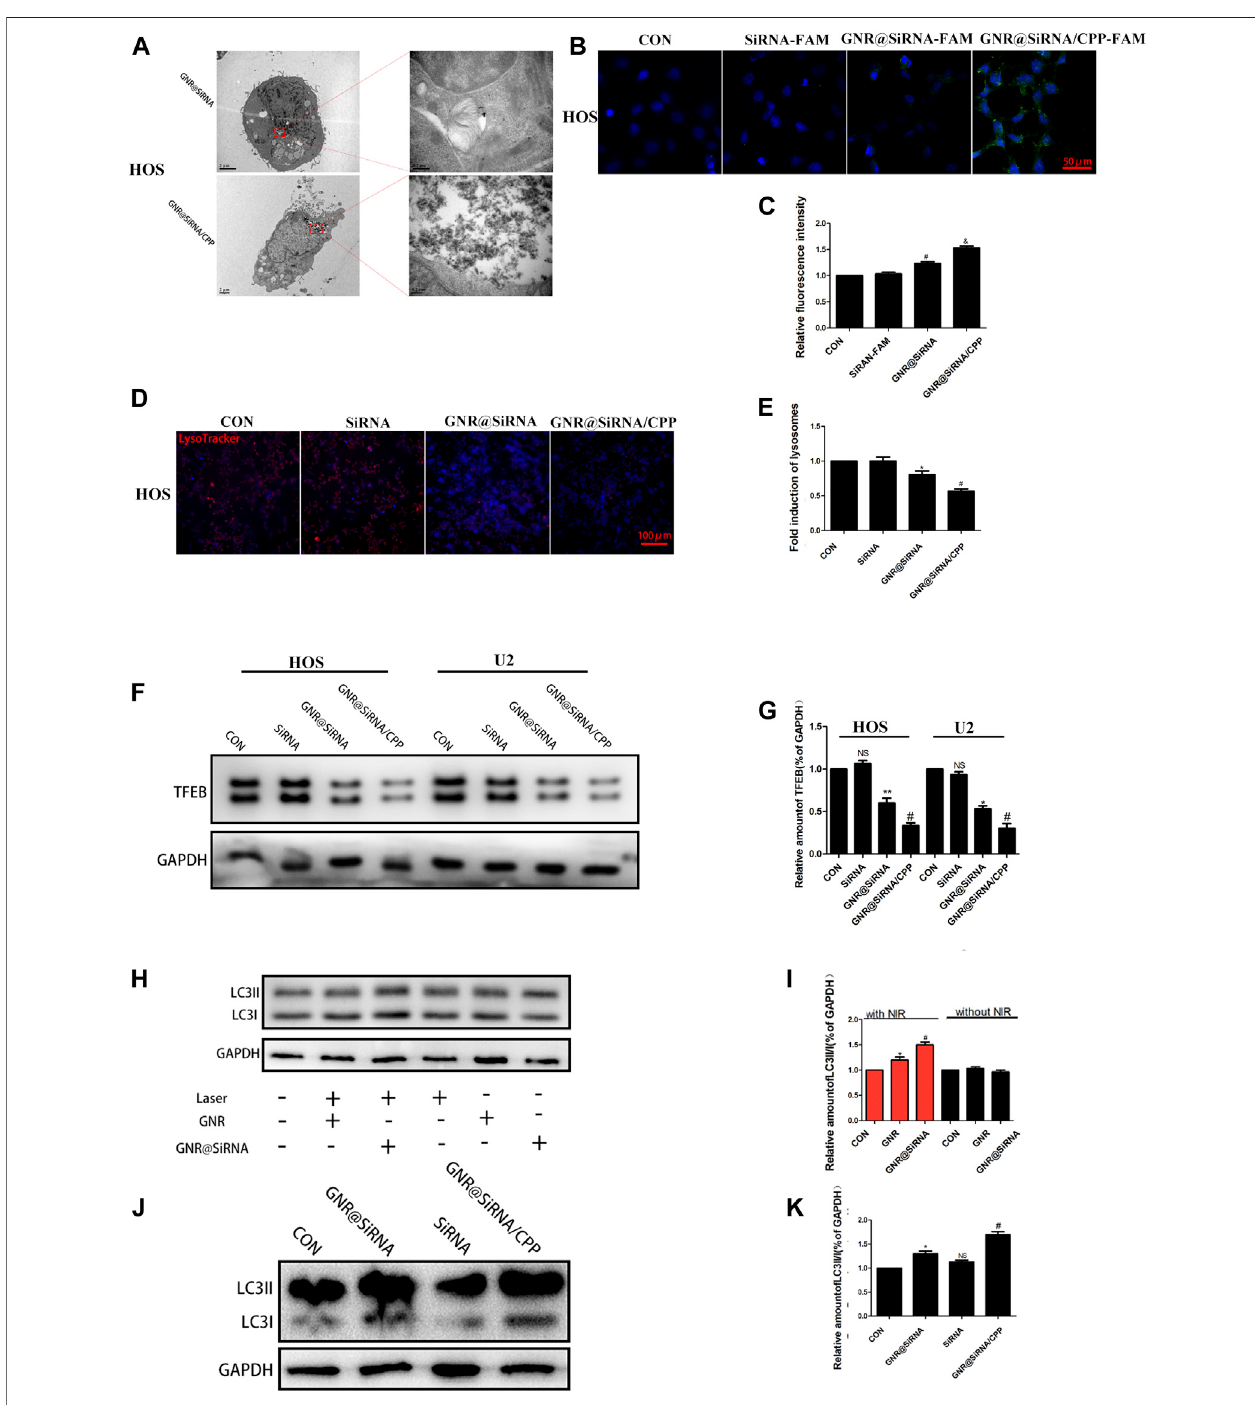
FIGURE3| Nanoplatformsinhibits lysosome formation. (A) TEMimages ofGNR@siRNAand GNR@siRNA/CPP inOScells. (B,C) Fluorescent images ofOScells incubatedwithsiRNA (labeledwiththegreen fl uorescentFAM),GNR@siRNA,andGNR@siRNA/CPP,respectively. (D,E) Confocal microscopic imagesofLysoTracker for lysosomes (red) in OS cells. (F, G) Protein expression and densitometric quanti fi cation of TFEB in different groups. (H – K) Protein expression and densitometric quanti fi cationofLC3Bindifferentgroups.( n (cid:2) 5pergroup;* p < 0.05vs.CONgroup,** p < 0.01vs.siRNAgroup, # p < 0.05vs.siRNAgrouporGNR@siRNAgroup; & p < 0.05 vs. GNR@siRNA